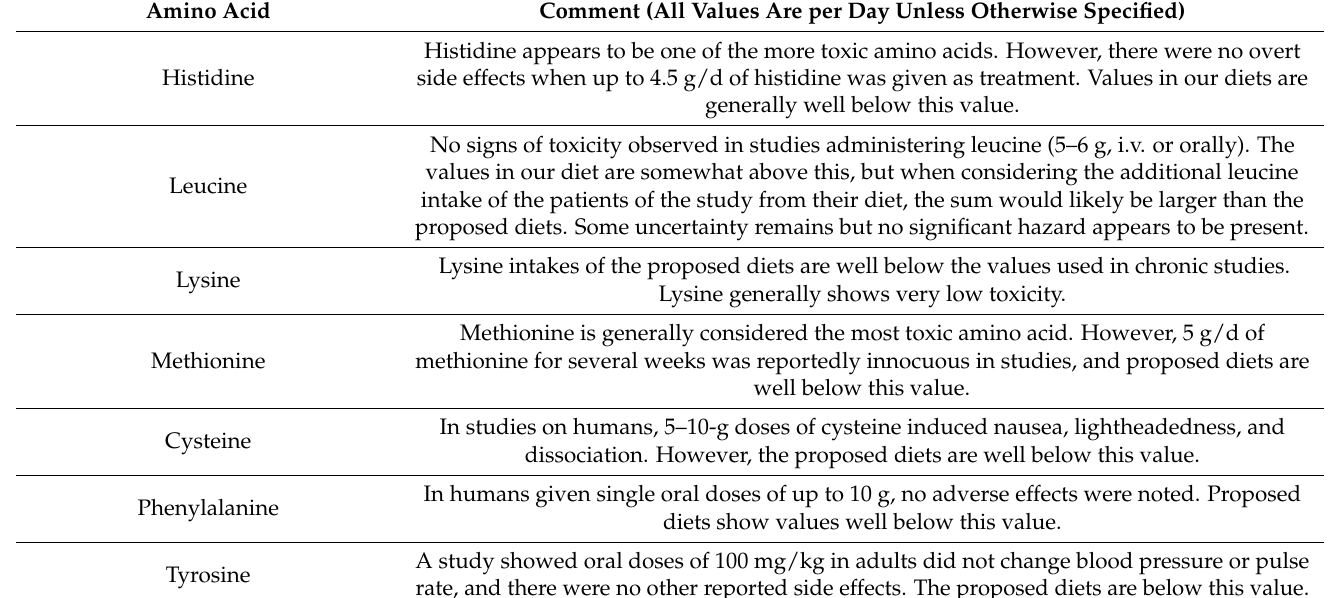
Table A2. Notes on safety of amino acid levels in our diets compared to a review of hazards.